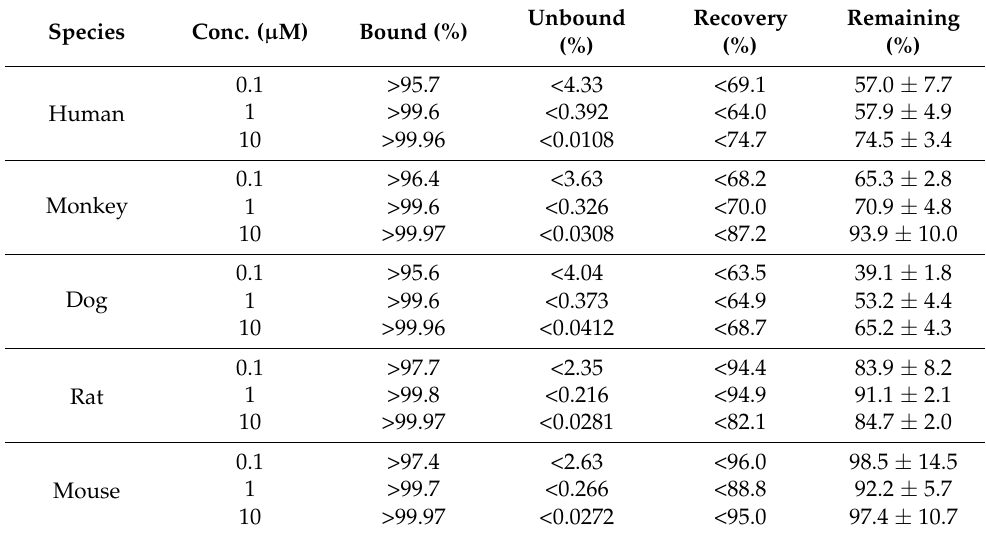
Table 7. The bound (%), unbound (%), recovery (%), and remaining (%) of ZB716 at 0.1, 1, and 10 µ M in human, monkey, dog, rat, and mouse plasma.